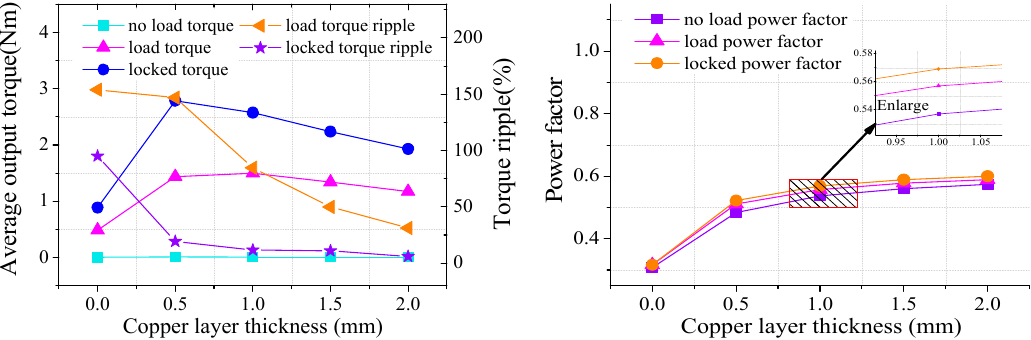
Figure 12. Influence of copper layer thickness on average output torque and power factor at no load, load, and locked.